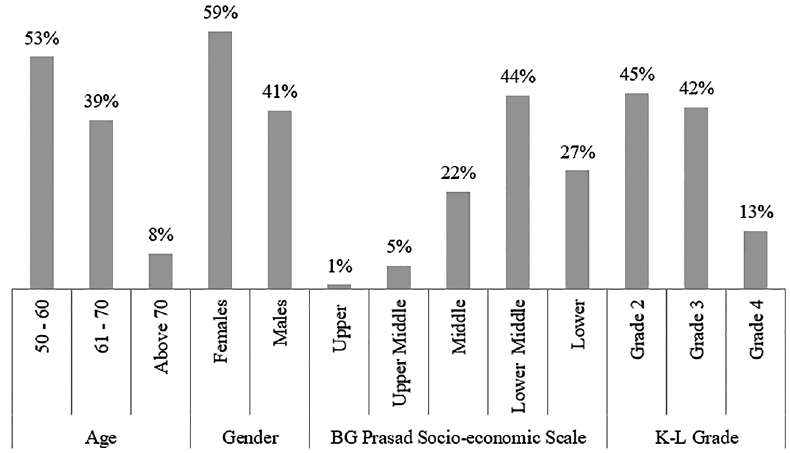
Figure 1. Age, Gender, BG Prasad socioeconomic scale, KL grade, BMI and history of smoking distribution of the study population.